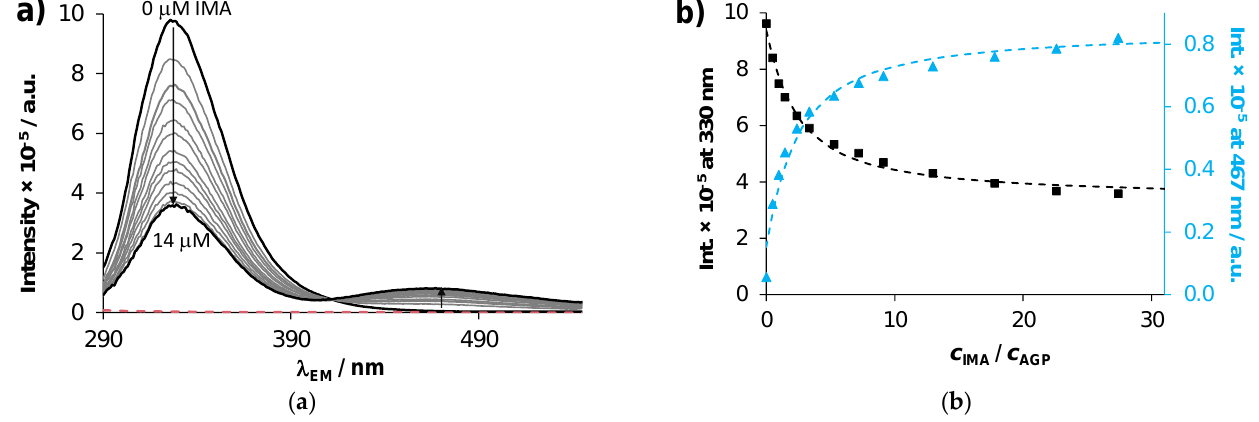
Figure 10. ( a ) Quenching of AGP fluorescence by addition of IMA and emission spectrum of IMA alone (red dashed line, 50 μM). ( b ) The measured and computed (dashed lines) emission intensities (Int.) at 330 nm ( ■ ) and 448 nm ( ▲ ) [ c AGP = 0.53 μM; c IMA = 0 – 47 μM; λ EX = 280 nm; pH = 7.4 (PBS); t = 25 °C]. Table 3. Binding constants ( K ’) reported in the literature and determined a in this study for the AGP – IMA and HSA – IMA systems under the indicated conditions.